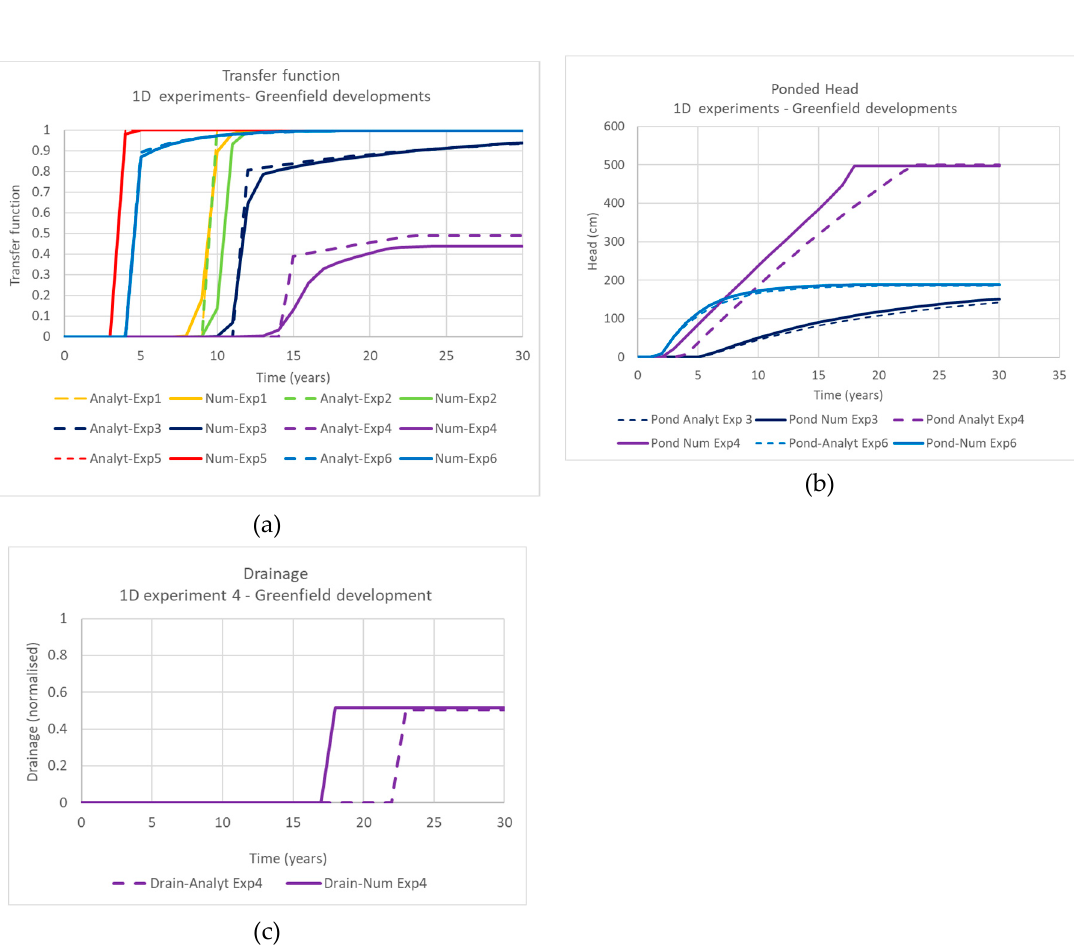
Figure 4. Of outputs from one-dimensional outputs from PerTy3 (semi-analyt-ical) (dashed) and FEFLOW (numerical) (solid) models ( a ) transfer functions; ( b ) ponded head and ( c ) normalized drainage volume.